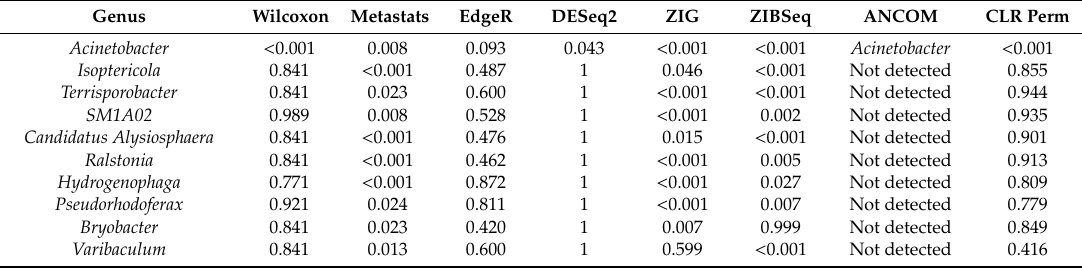
Table 2. Top 10 genus-level microbiome biomarkers significantly di ff erentially distributed between the ovarian cancer and benign ovarian tumor groups.